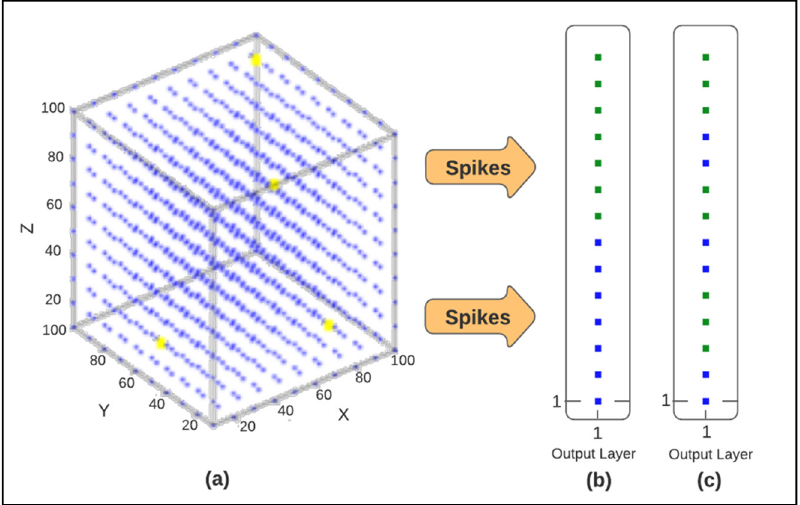
Figure 6. Architecture of the Spiking neural networks (SNN) cube trained using 60 samples ( a ), with the output layer colored by the true ( b ) and predicted ( c ) labels of the samples.